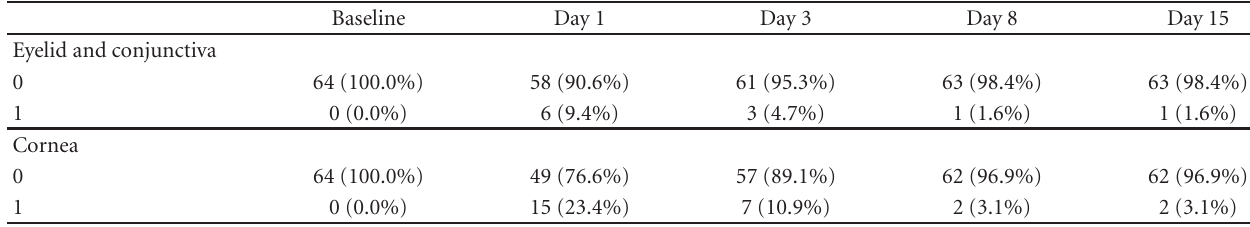
Table 2: Ocular signs of inflammation observed in eyes, n